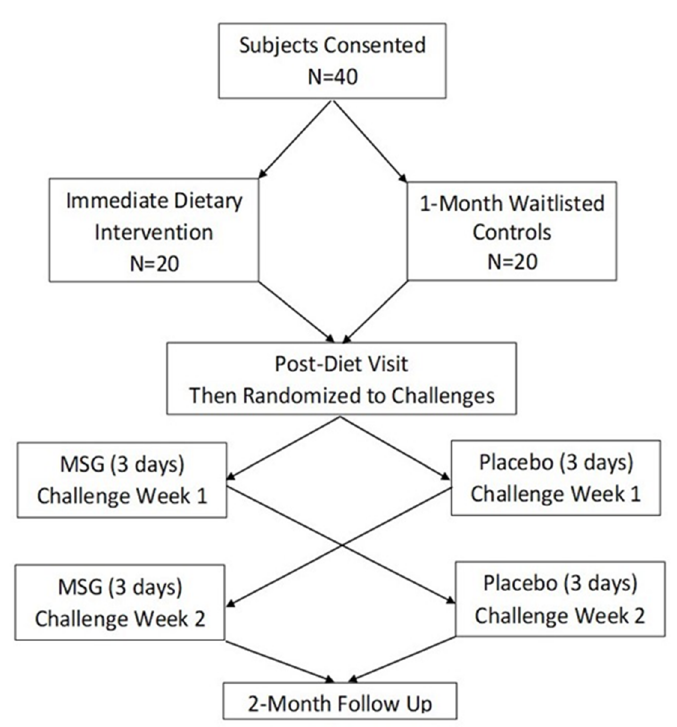
Figure 1. Study design. MSG = monosodium